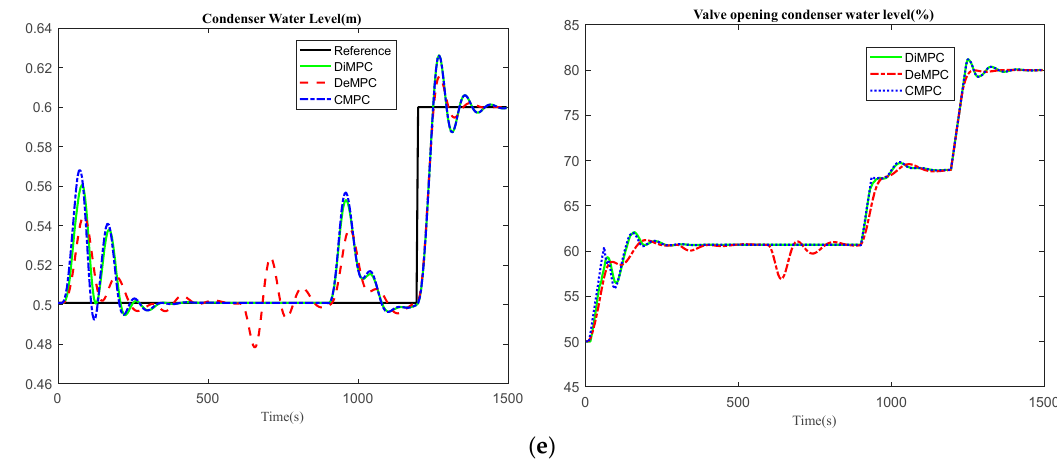
Figure 8. The responses of the steam/water loop under the DeMPC, CMPC and DiMPC for ( a ) drum water level control loop, ( b ) deaerator water level control loop, ( c ) deaerator pressure control loop, ( d ) condenser water level control loop and ( e ) exhaust manifold pressure control loop (The figures on left hand indicate the outputs, and on the right hand indicate the inputs).